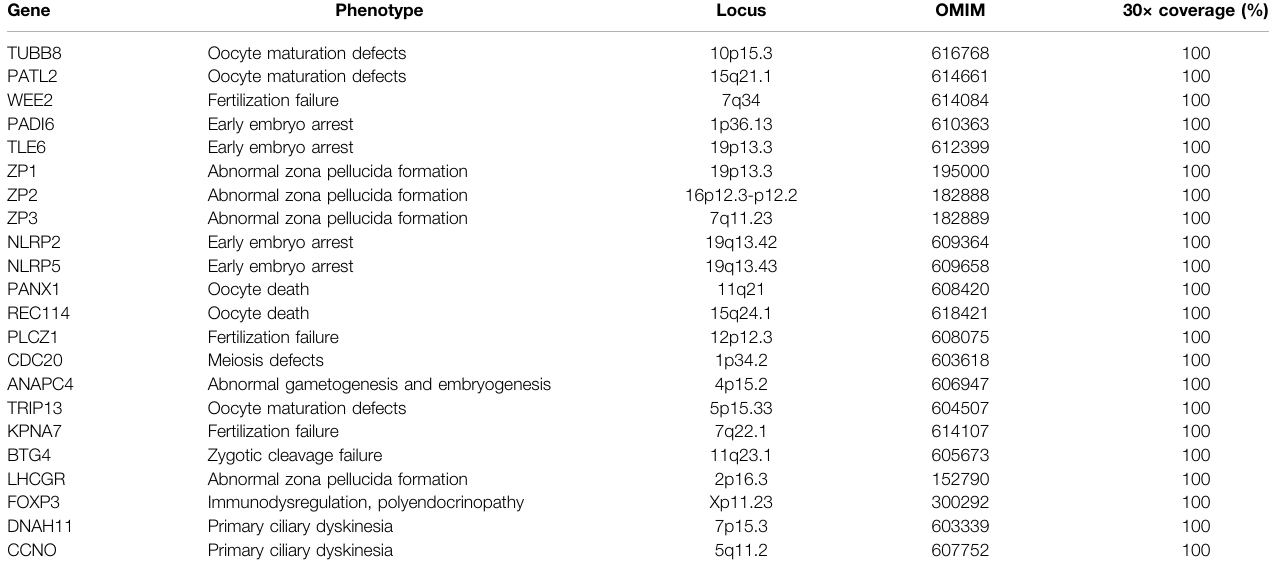
TABLE 1 | Genes included in the target sequencing panel and their phenotypes.